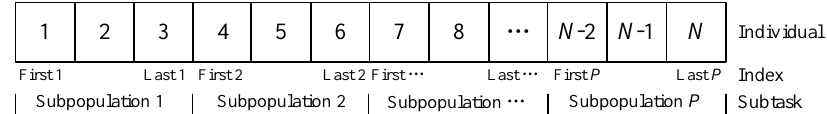
Energies 2017 , 10 , 163